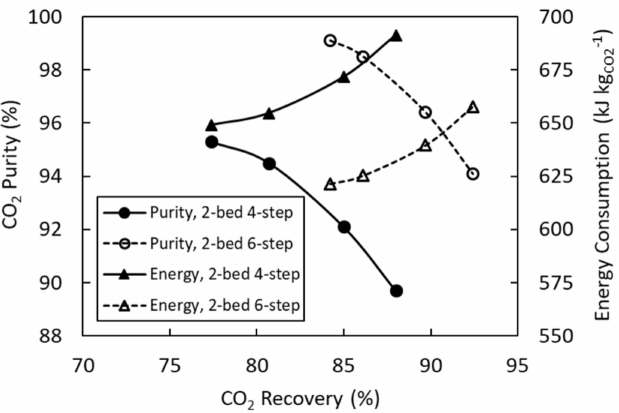
Figure 8. CO 2 purity and specific energy consumption against CO 2 recovery for the VPSA process with varying purge-to-feed ratio and desorption pressure at 0.05